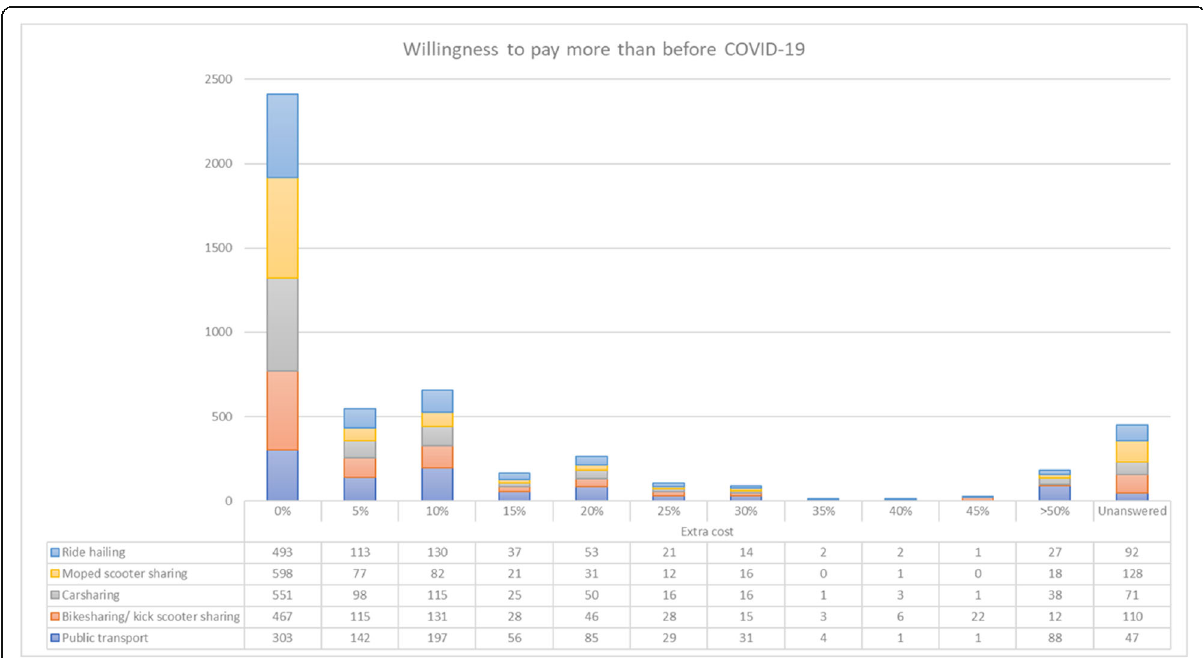
Fig. 4 Willingness to pay more for special sanitising measures, compared to